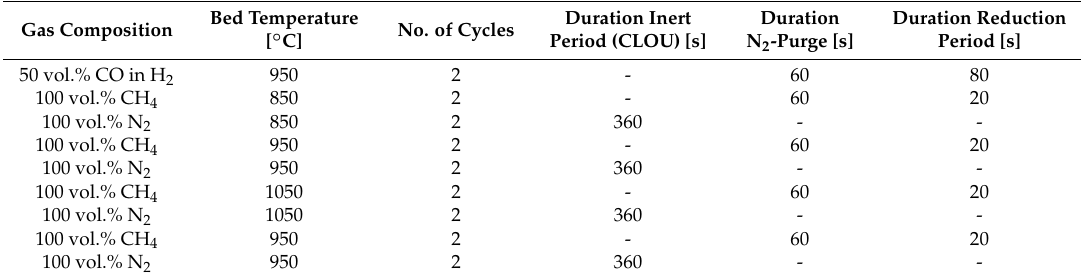
Table 1. Experimental procedure used to investigate oxygen release and gas